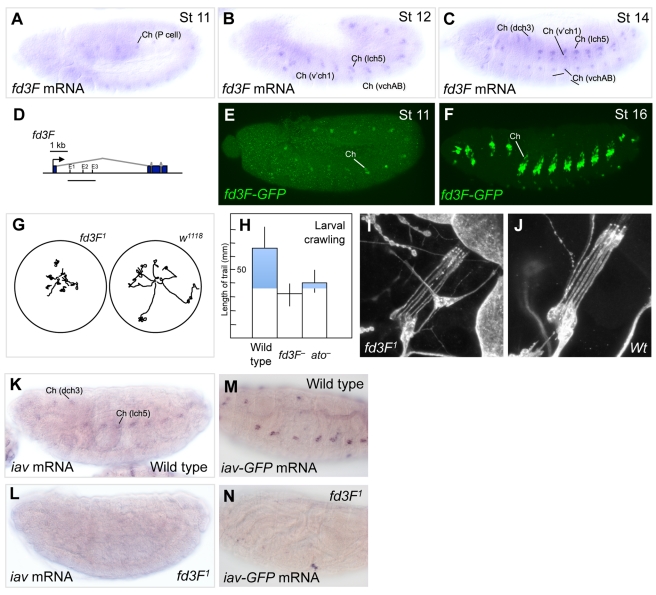

fd3F is downstream of ato function and required for Ch neuron function.(A–C) fd3F is expressed exclusively in Ch lineages from the precursor stage to differentiation. lch5, dch3, v'ch1, and vchAB are designations of specific Ch neurons or neuron groups [54]. (D) Schematic of fd3F gene, showing the location of the fragment tested for enhancer activity (E,F). The fd3F enhancer fragment drives GFP in Ch lineages. (E) Expression at stage 11 in Ch precursors. (F) Expression at stage 16 exclusively in Ch lineages. (G) Traces of larval movement for 2 min after being placed in middle of Petri dish. (H) Chart of larval locomotion test (as in (G)) of wildtype, fd3F
−, and ato
− larvae. Locomotion is significantly reduced in fd3F
− and ato
− compared to wildtype (by t test, p = 1×10−6 and 5.7×10−6, respectively), consistent with defective Ch neurons. (I,J) Cluster of five Ch neurons in one abdominal segment of fd3F
− (I) and wildtype (J) larva as revealed by anti-HRP staining. Ch neurons are grossly normal in the mutant. (K,L) Expression of iav is reduced in fd3F mutant embryo (L) compared to wild type (K). (M,N) Similarly, expression of an iav-GFP reporter gene construct (FGN, unpublished) is missing in fd3F mutant embryo (M) compared to wild type (N).